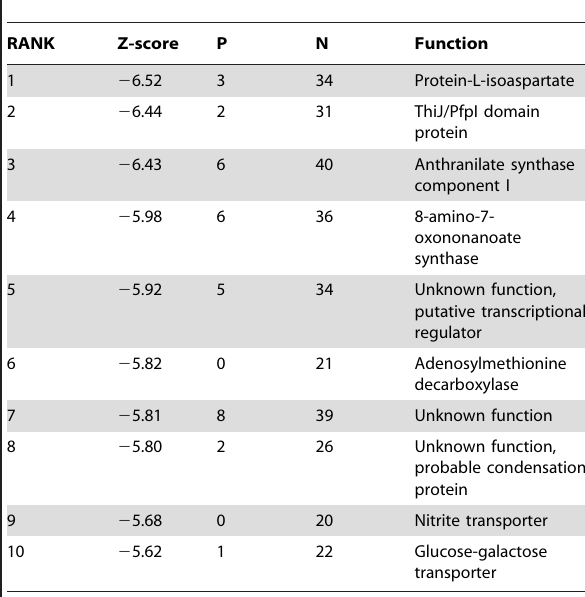
Table 3. Top 10 ranking pathogenic protein families and annotated functions of their proteins for TM- Gammaproteobacteria model.